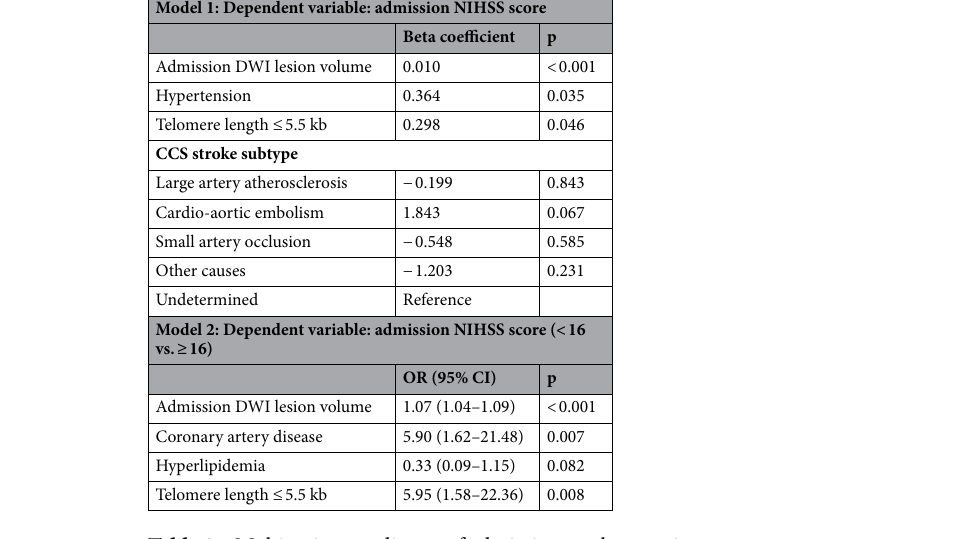
Table 3. Multivariate predictors of admission stroke